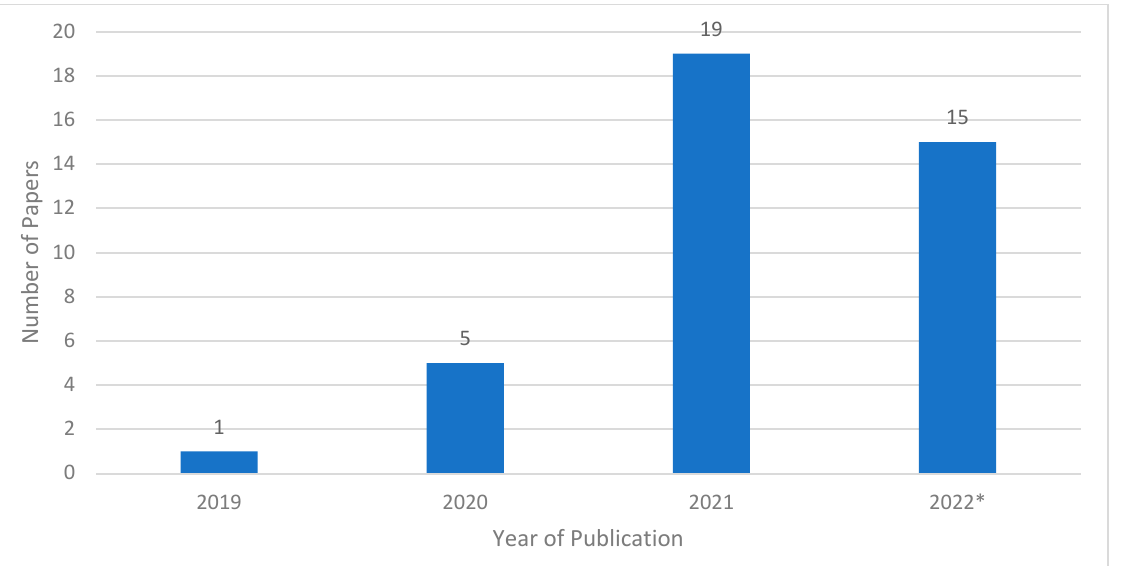
Figure 6. Categorisation of papers using ranking by Journal Impact Factor (JIF) Quartile.